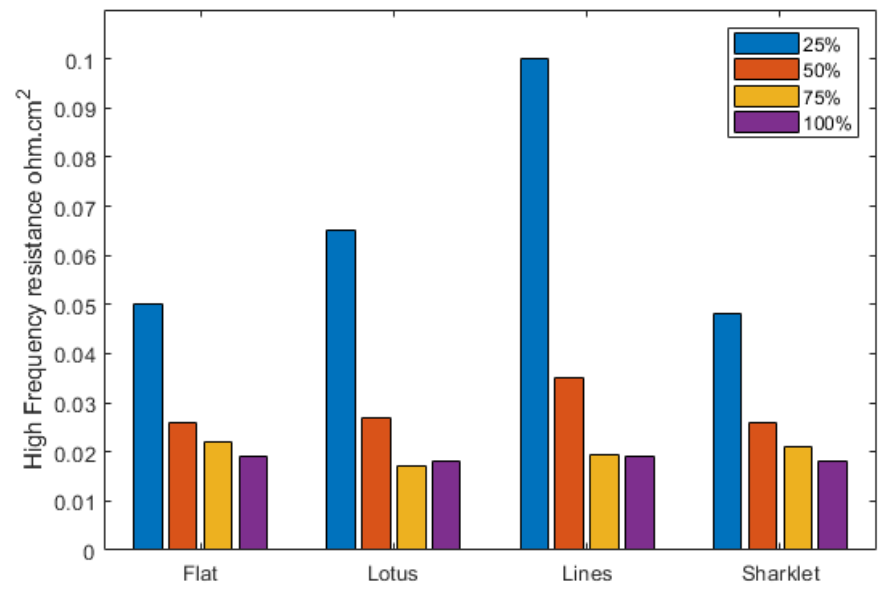
Figure 5. High-frequency resistance across the different humidity levels for each Figure 5. High ‐ frequency resistance across the different humidity levels for each pattern.